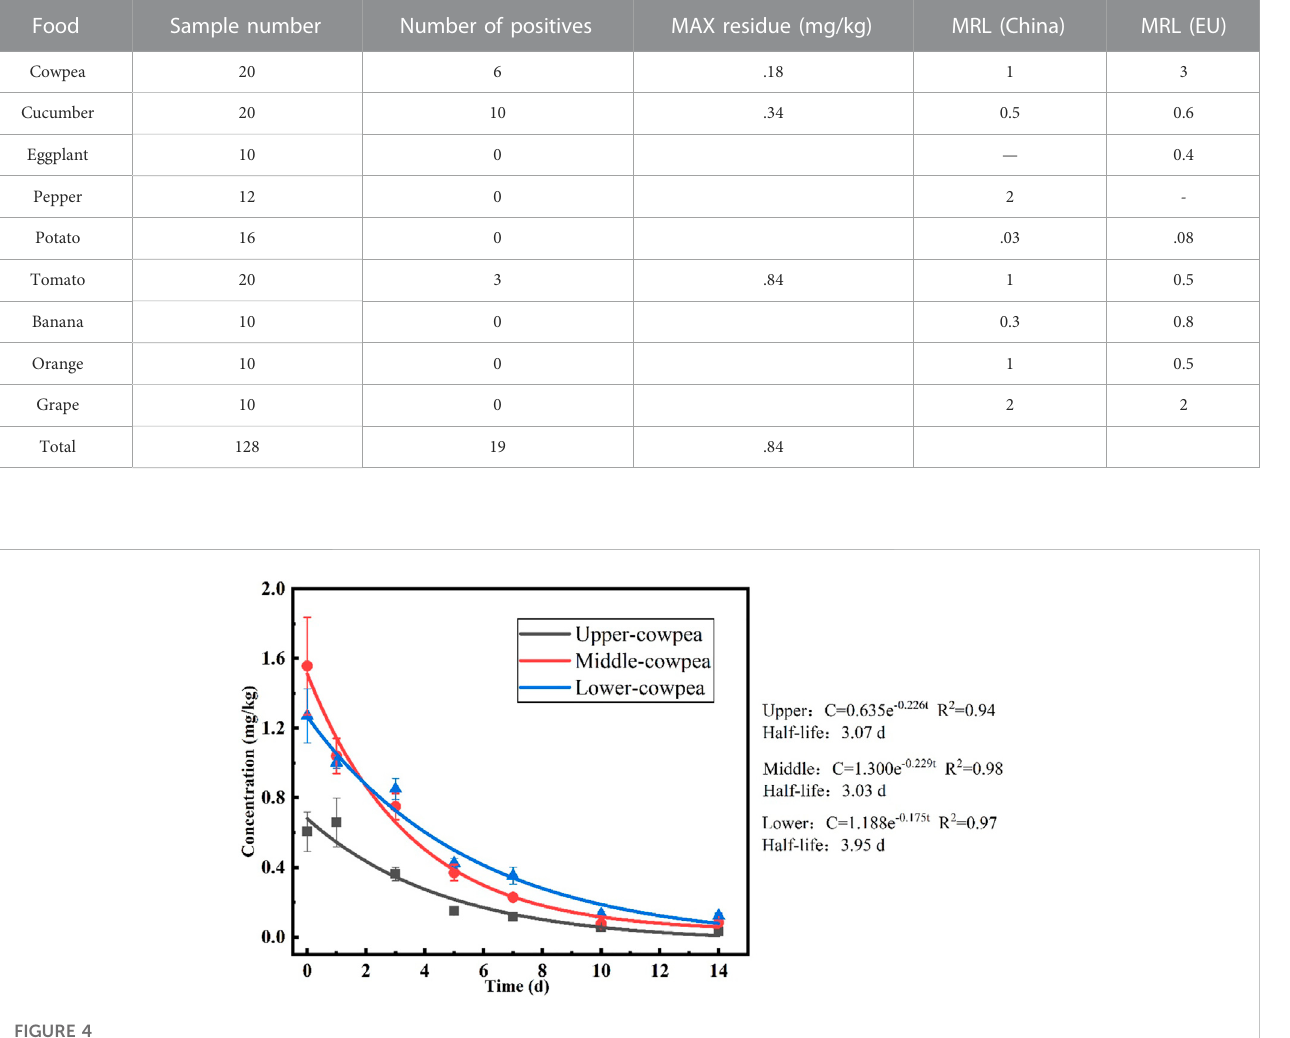
TABLE 4 Residue of fl uopyram in fruits and vegetables in Sanya.